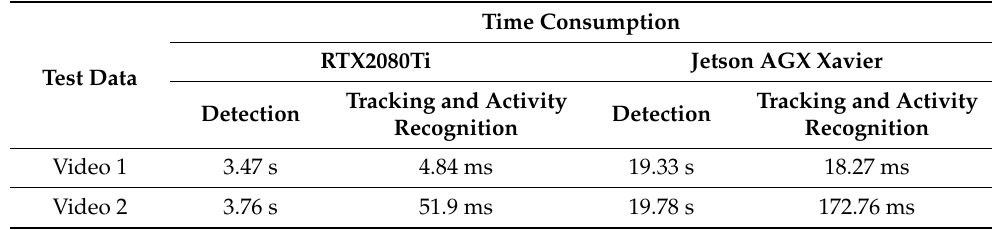
Table 3. Time consumption comparison of the algorithm on different computing